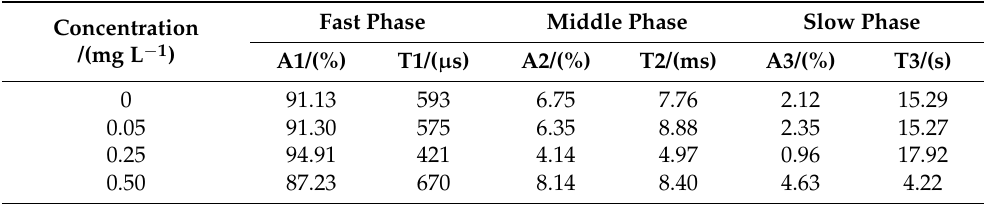
Table 1. Decay kinetics of flash-induced variable fluorescence in Synechocystis sp. PCC 6803 was treated with different cadmium concentrations for 72 h. The curves were analyzed by using three exponential components (fast, middle, and slow phases).